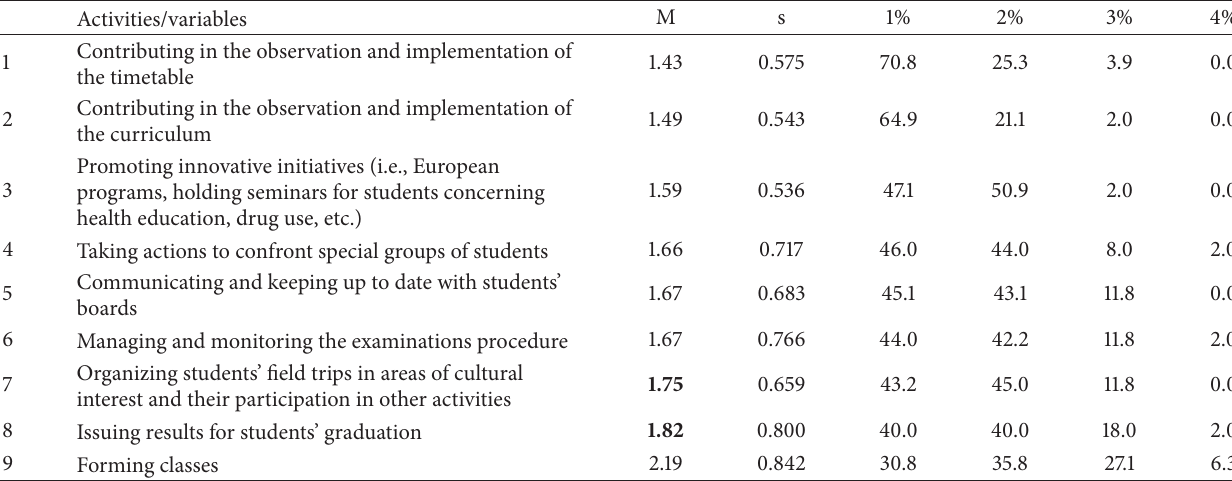
Table 2: The significance of activities related to the learning and the education of the